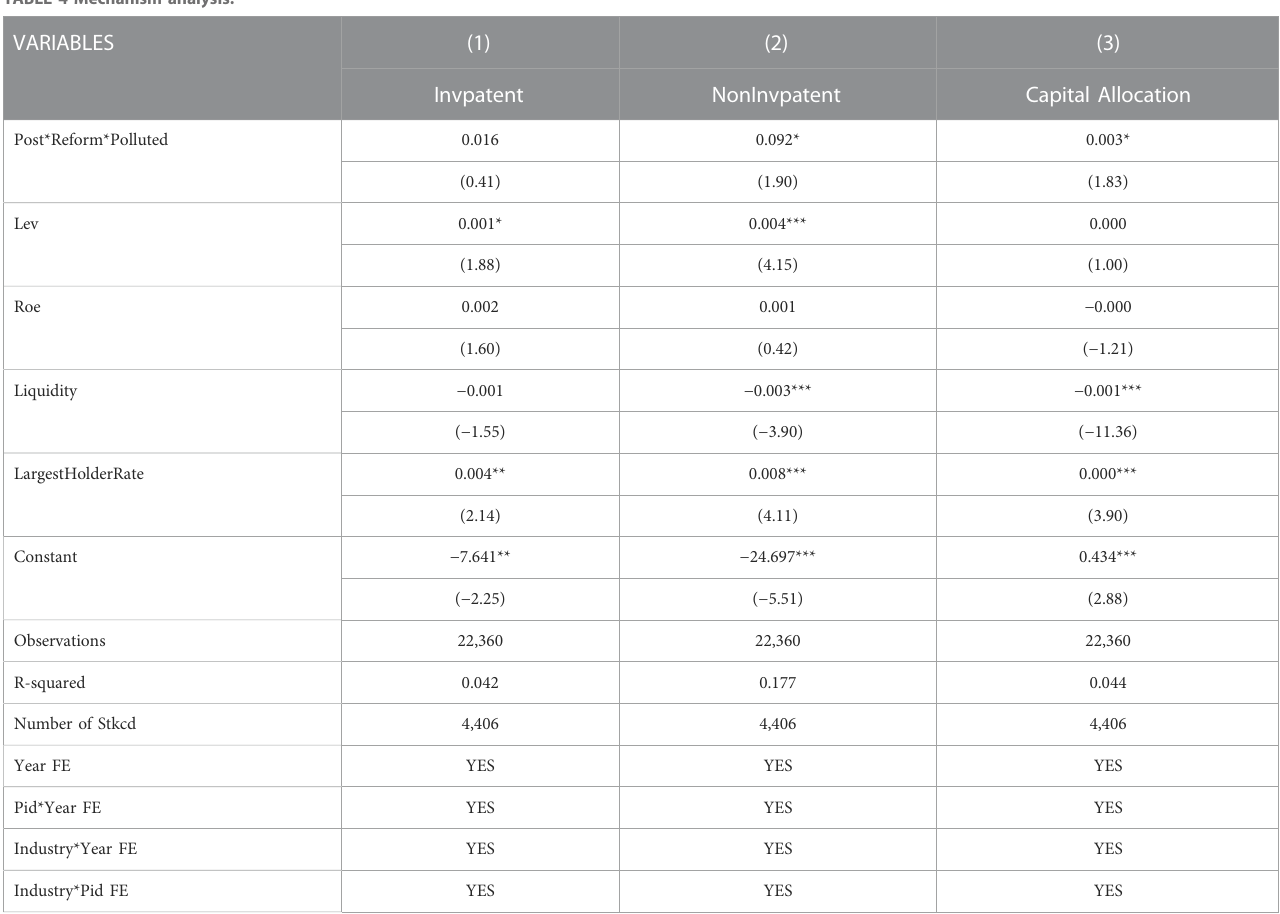
TABLE 4 Mechanism